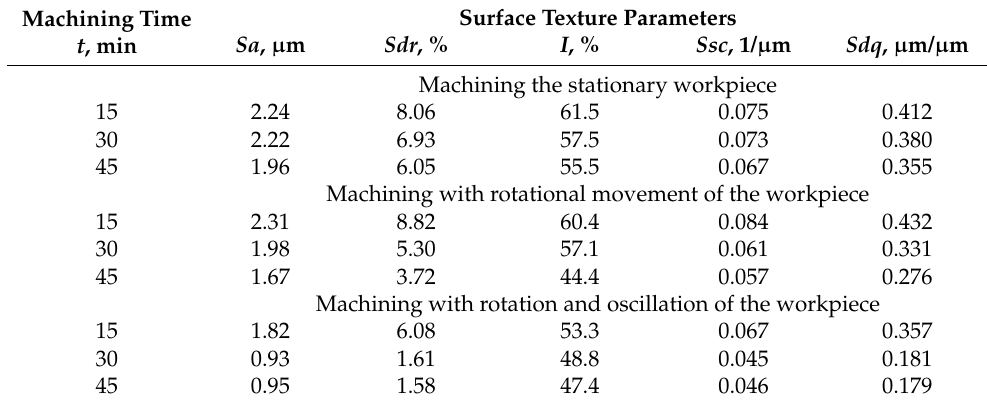
Table 2. Selected results obtained during the first stage of the experimental research.